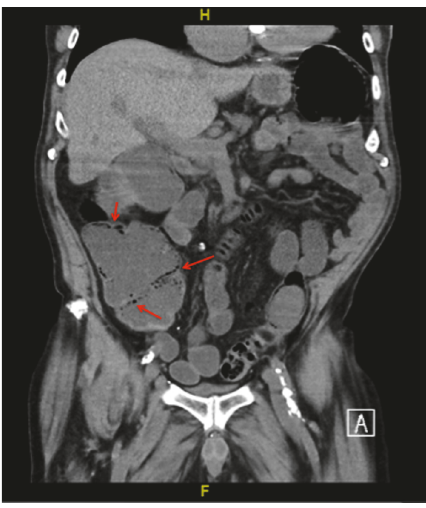
Figure 2: Coronal view with colonic wall thickening and submu- cosal and intraluminal air (arrow).